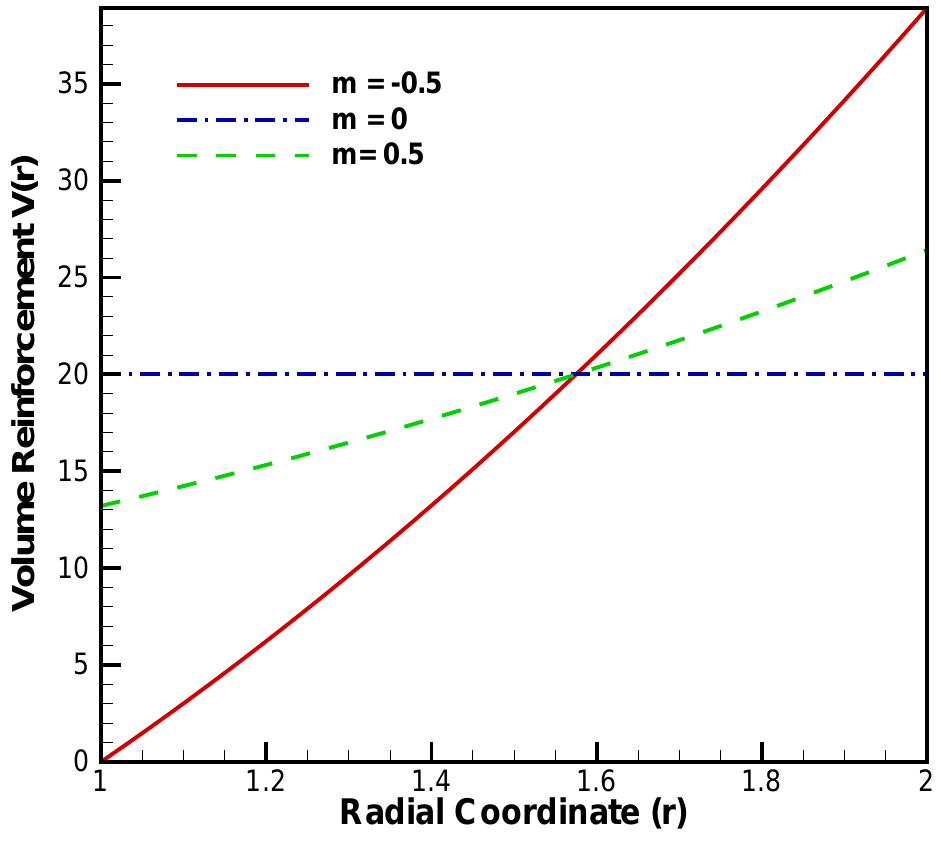
Figure 20. Quadratic volume reinforcement (vol %) of SiC p in Al metal matrix along the radius r (in cm) of the